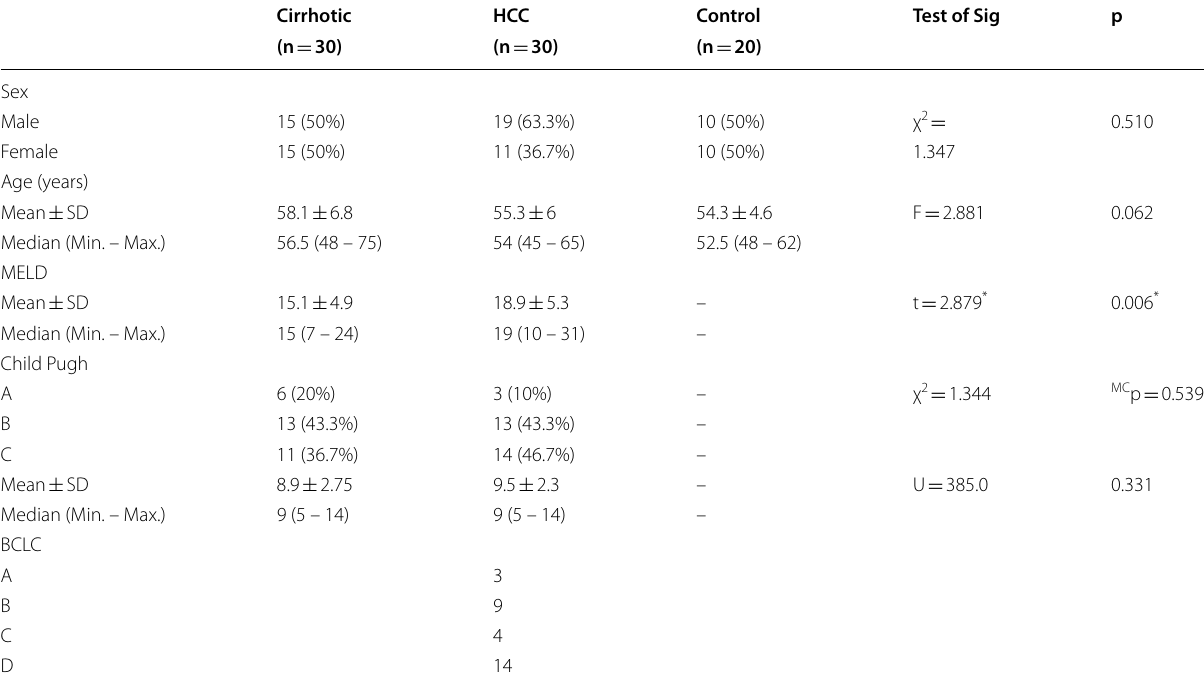
Table 1 Comparison between the three studied groups according to different parameters